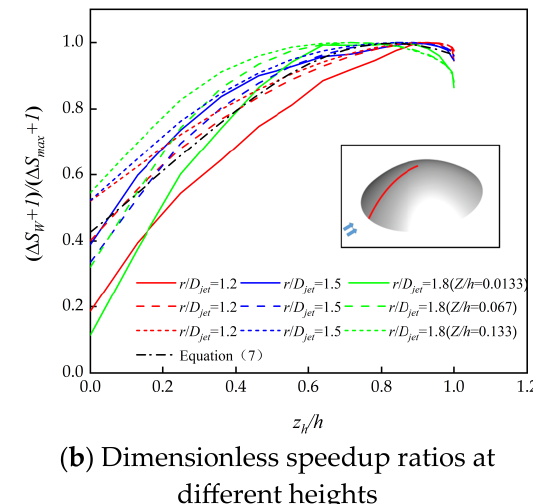
Figure 7. Speedup ratio along the windward side of the hill model.